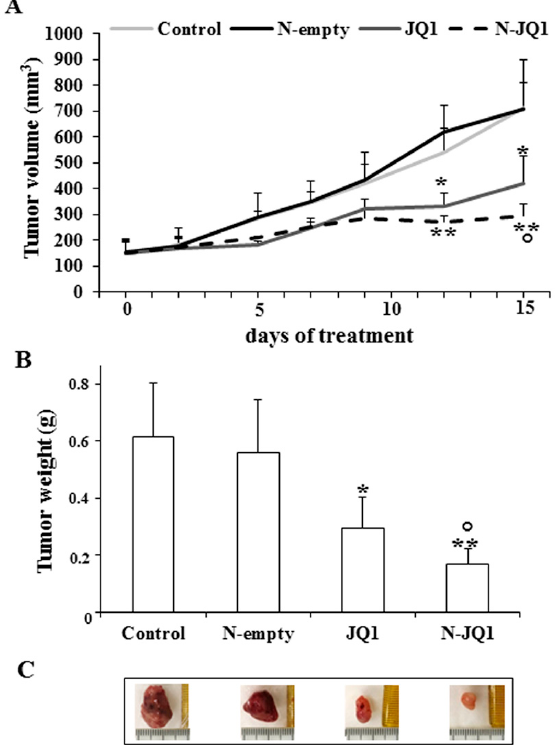
Figure 4. Effects of N-JQ1 treatment on xenograft tumor growth obtained after injection of MDA-MB 231 cells into the intrascapular region of female athymic nude mice. JQ1 (20 mg/kg) diluted in PBS + 5% PEG 400 + 5% TWEEN 80 (JQ1), nanoparticles containing JQ1 20 mg/Kg (N-JQ1), unloaded nanoparticles (N-empty) and PBS + 5% PEG 400 + 5% TWEEN 80 (Control) were administered by intraperitoneal injection for 15 days (5 days a week) as described in Methods. ( A ) tumor volume during the treatment; ( B ) tumor weight at sacrifice. Values are expressed as the mean of animal groups ± SD. Statistical analysis was performed by using the one-way ANOVA test. * p < 0.05, ** p < 0.01 vs. Control or empty nanoparticles; ° p < 0.05 vs. JQ1. ( C ) images of representative individual tumors for each group of